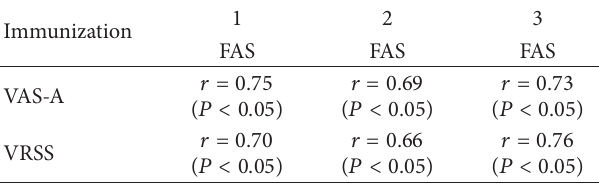
Table 4: The Pearson correlation